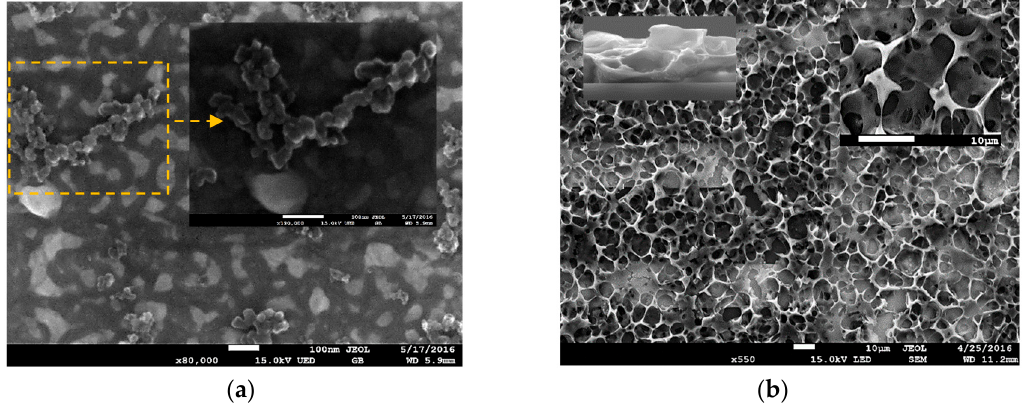
Figure 8. ( a ) SEM images of CB (black pearl 2000). A CB structure at higher magnitude is shown in the inset. Scale bar 100 nm; ( b ) SEM image of thin PVDF-HFP/CB film on the IDE. Note the porous structure. The film cross section is shown in the inset top left. The pores at higher magnification are shown in the inset top right. Scale bar 10 µm.